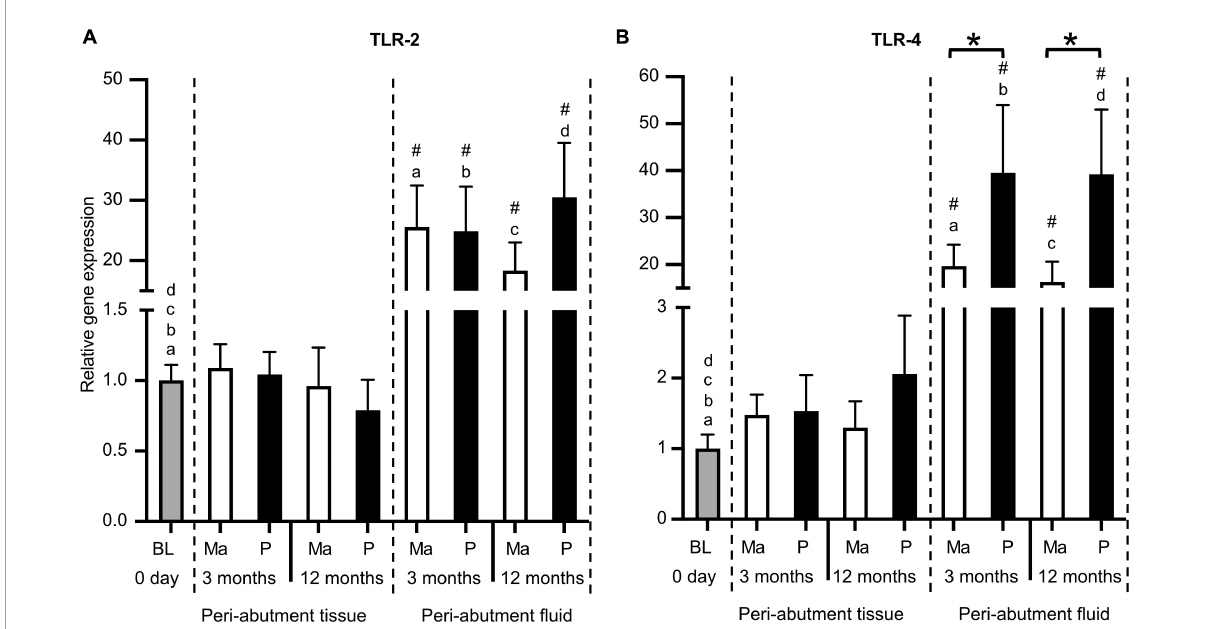
FIGURE3 Gene expression of Toll-like receptors. (A) Toll-like receptor 2 (TLR2). (B) Toll-like receptor 4 (TLR4). The column graphs show the relative gene expression at baseline (BL) and in the peri-abutment tissue and peri-abutment fluid at machined (M) and electropolished (P) abutments after 3 and 12 months of implantation. Statistically significant differences ( p < 0.05) between BL and either compartment (“Peri-abutment tissue” or “Peri-abutment fluid”) and between the two compartments are indicated by similar small letters and hash signs, respectively. The differences between machined and electropolished abutments for each compartment are indicated by bars and